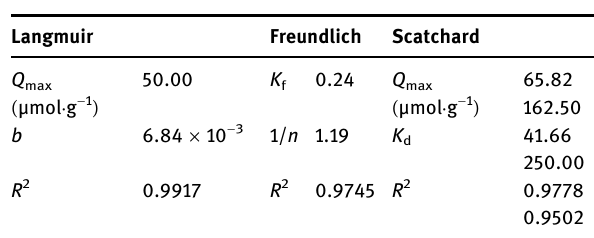
Table 4: Fitting parameters of the Langmuir, Freundlich, and Scatchard adsorption